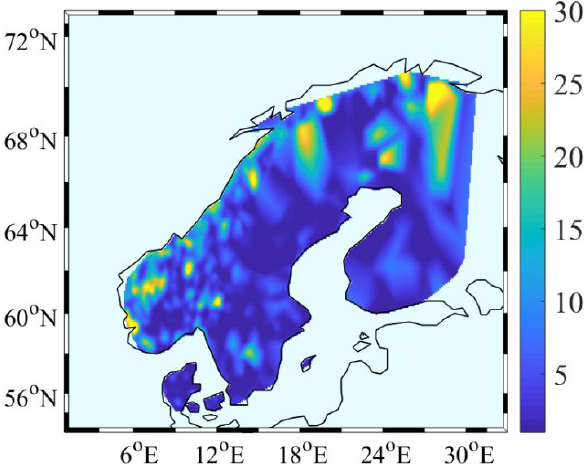
Fig. 5. The local estimates of the error of the NKG2015 geoid model with a confidence interval of 68%